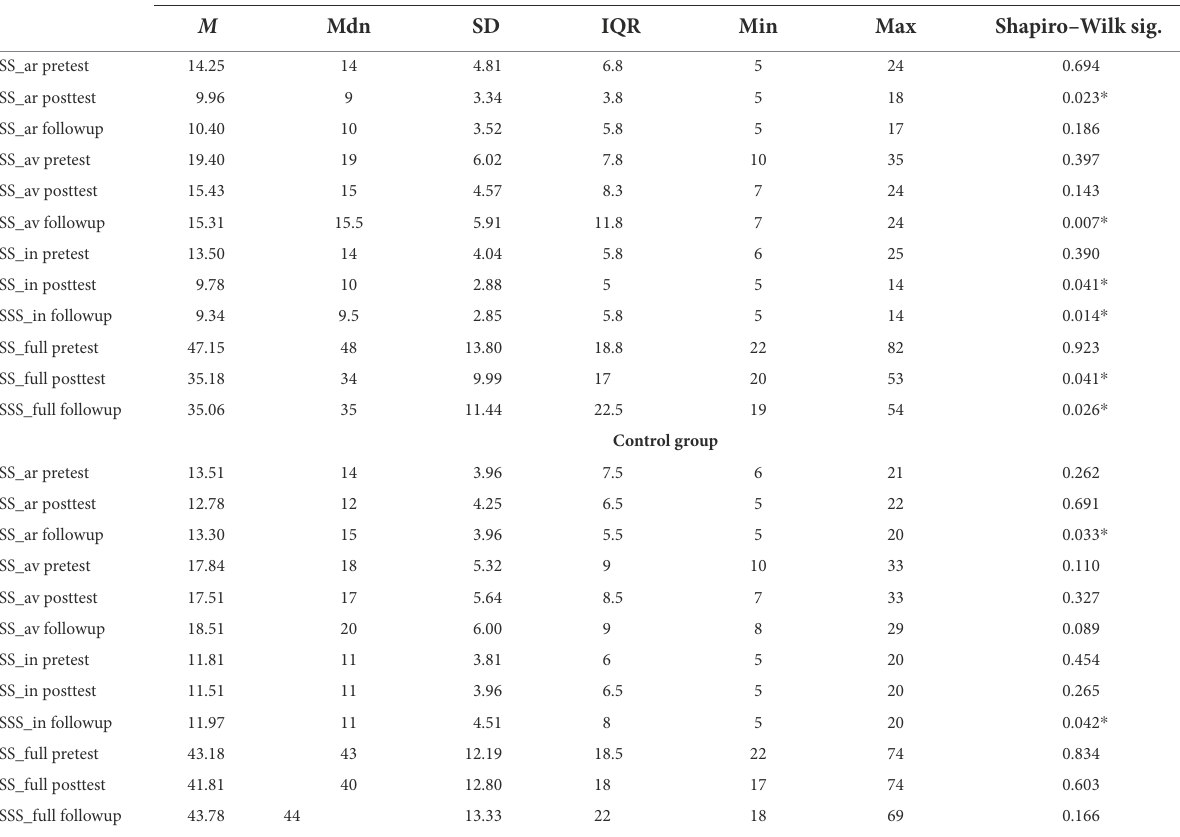
TABLE 3 Descriptive statistics for secondary traumatic stress and